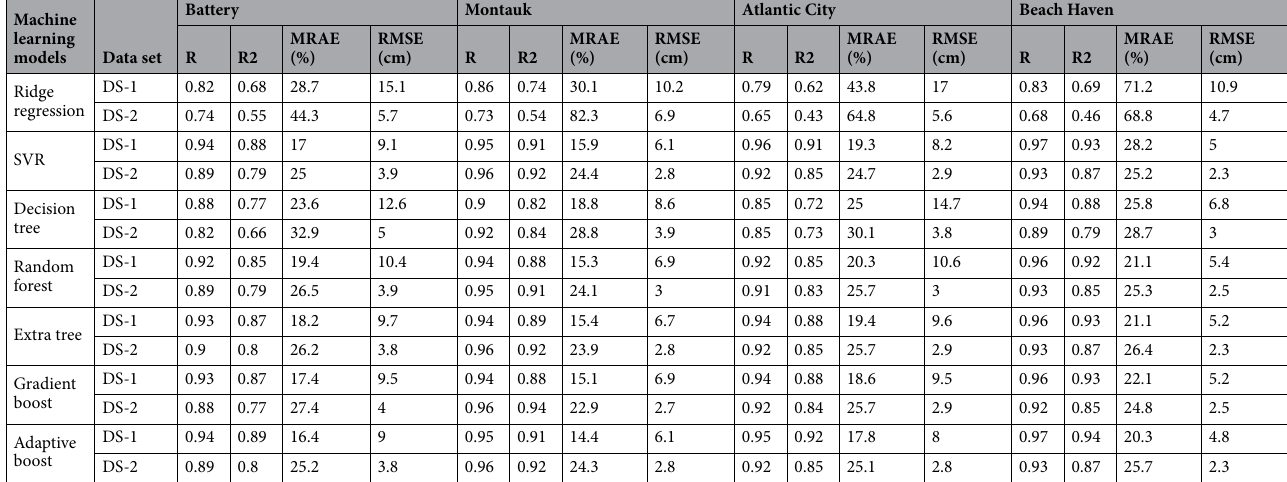
Table 2. Performance metrics of the seven ML models at the four study sites using the test data set.